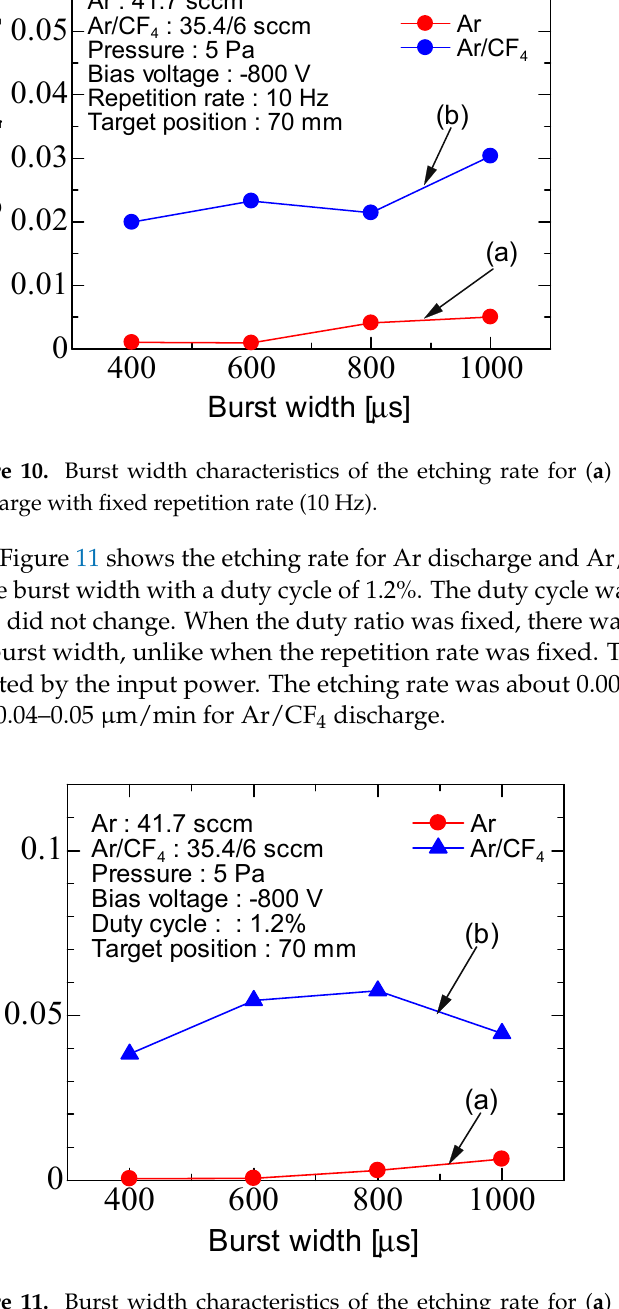
Figure 11. Burst width characteristics of the etching rate for ( a ) Ar discharge and ( b ) Ar/CF 4 discharge with fixed duty cycle (1.2%).